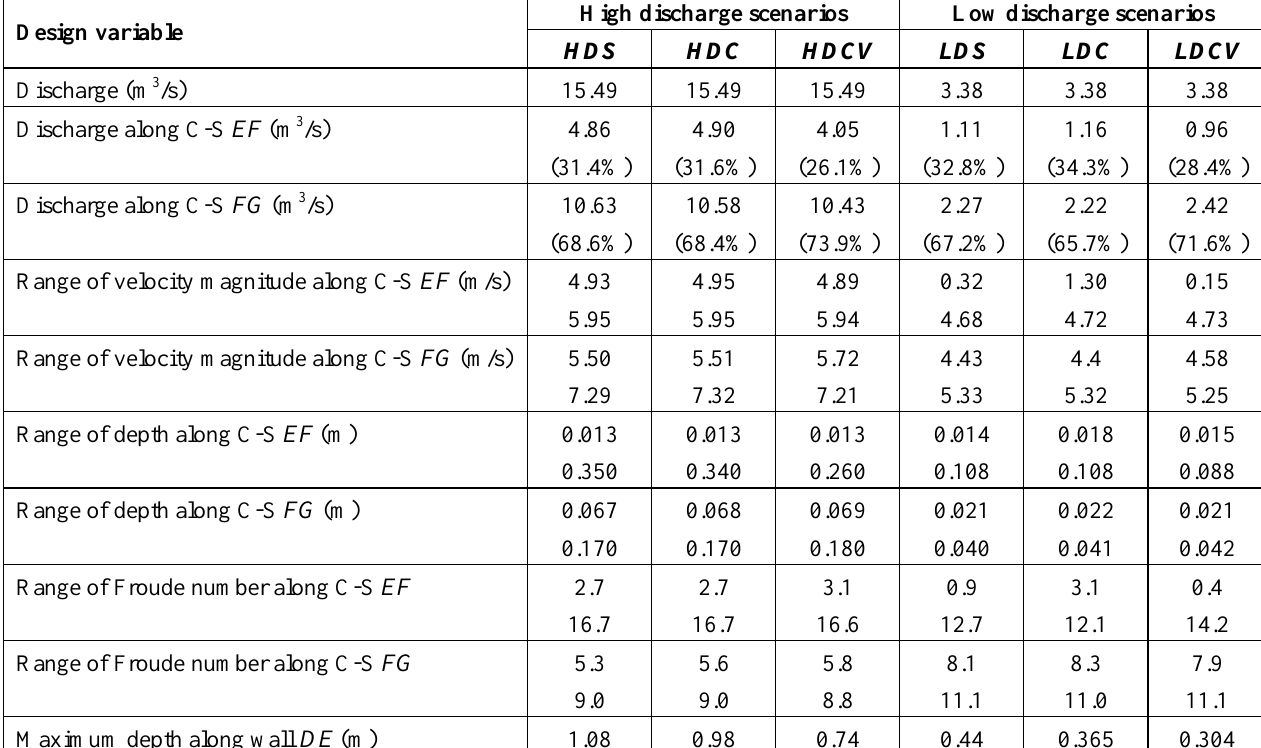
Table 2. Design variables/parameters for different flow scenarios.